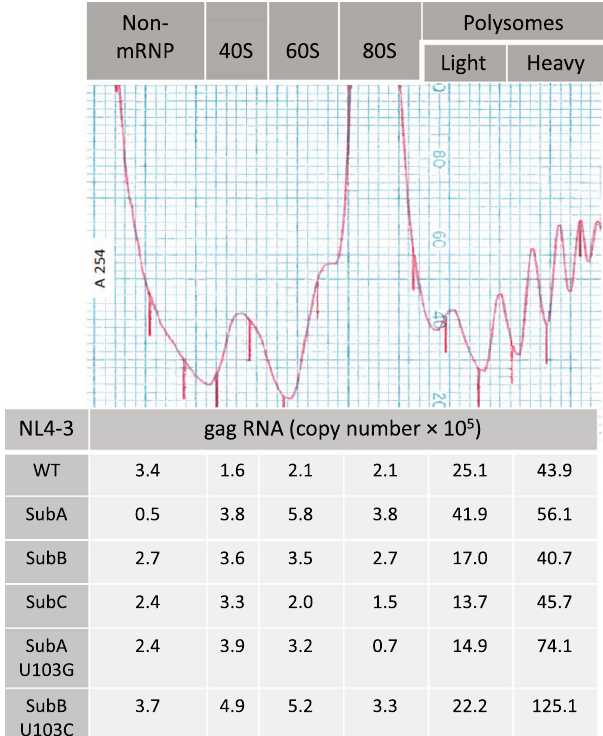
Figure 4. Quantitative analysis of HIV polysomes documents equivalent translation activity of dimer- and monomer-prone RNA and up-regulation by addition of U103 substitution. Representative ribosomal profile with labeling of RNP populations and distribution of gag RNA quantified by RT-qPCR. Results were similar between clones, with exception that SubA U103G and SubB U103C significantly increased HIV polysomes. Standard curves were used to measure gag RNA copy number in these samples.